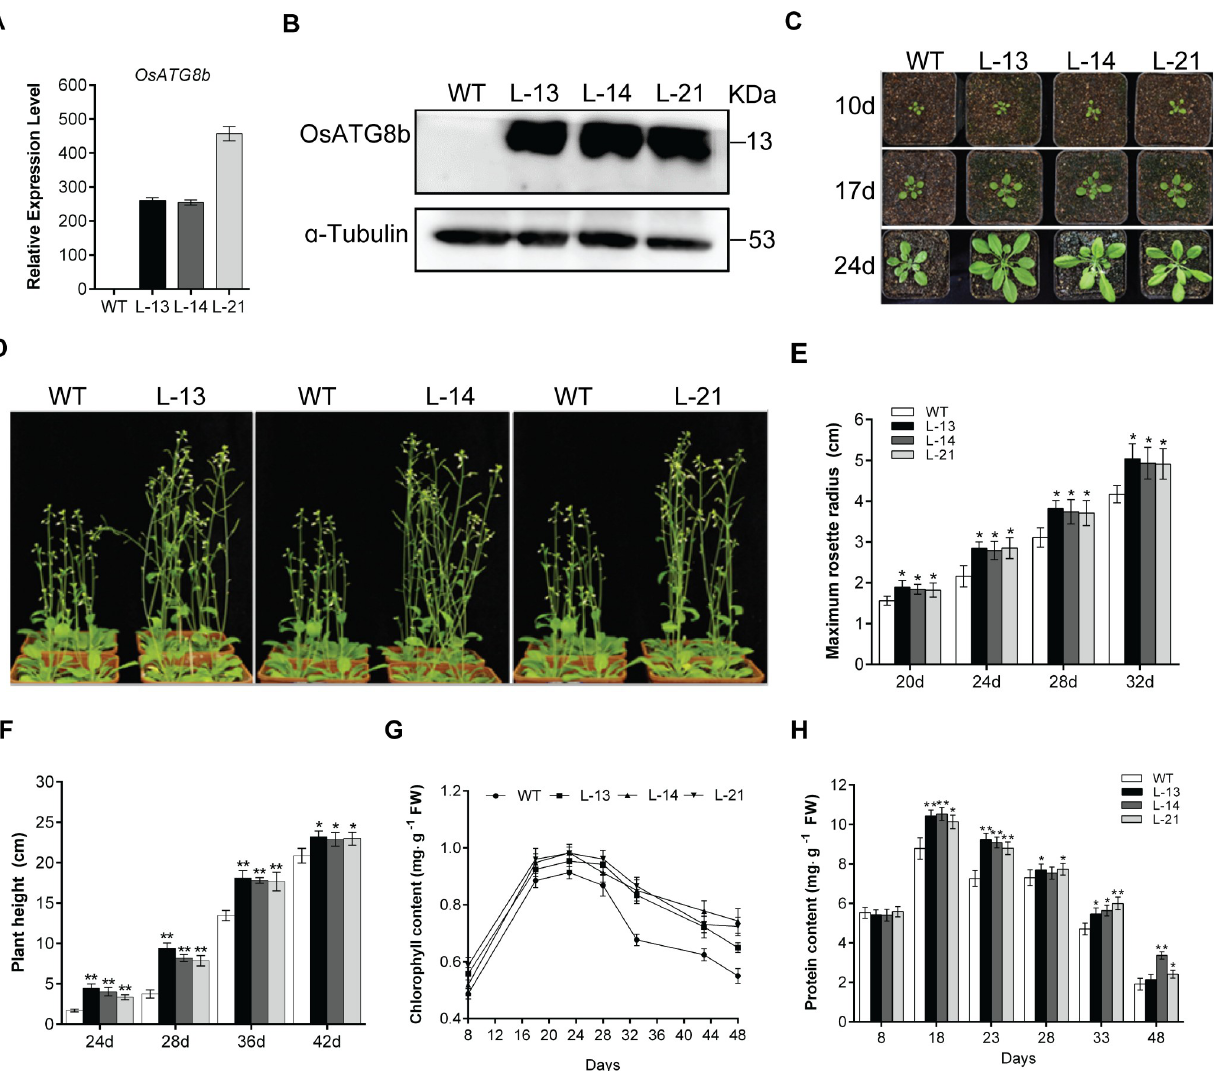
Fig 2. Overexpression of OsATG8b promotes growth of transgenic Arabidopsis. 8-day-old seedlings were transferred to soil and cultivated under a long-day photoperiod. (A) Expression level of OsATG8b in 14-day-old seedlings of transgenic lines and WT. (B) Immunoblot analysis of the accumulation of OsATG8b in 14-day-old seedlings of the WT and 35S-OsATG8b transgenic lines (L-13, L-14, L-21) with a polyclonal anti-OsATG8b antibody. Equal protein loads were confirmed by immunoblot analysis with an α -tubulin antibody. (C) Panels from top to bottom show phenotypic observations of transgenic lines and WT at 10 days, 17 days and 24 days after transfer to soil, respectively. (D) Side view of transgenic lines and WT at 42 days after transfer to soil. (E)-(H) The maximum rosette radius, plant height, chlorophyll content and soluble protein content of transgenic lines and WT. Values are means ± SD of three biological replicates (n = 24), � P < 0.05, �� P < 0.01